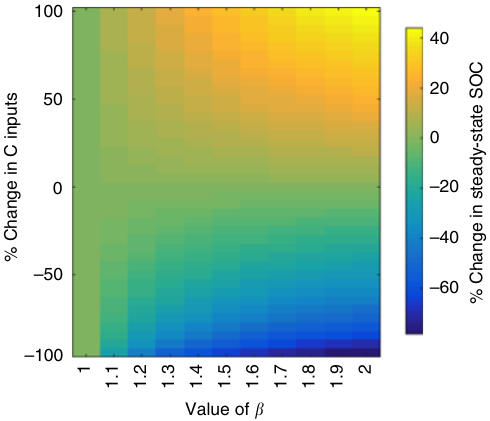
Fig. 4 Percent change in the SOC steady state following a range of step changes in C inputs with a range of β values in the two-pool microbial model. The value of β depicts the strength of density-dependent microbial turnover, where β = 1 gives the widely used two-pool microbial model without density-dependence and β = 2 gives a strong